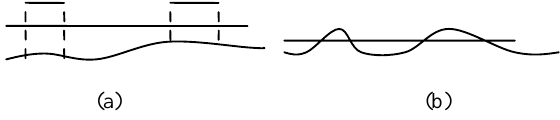
Figure 2. (a) The empty holes caused by building or vegetation. (b) The empty hole caused by small higher area.